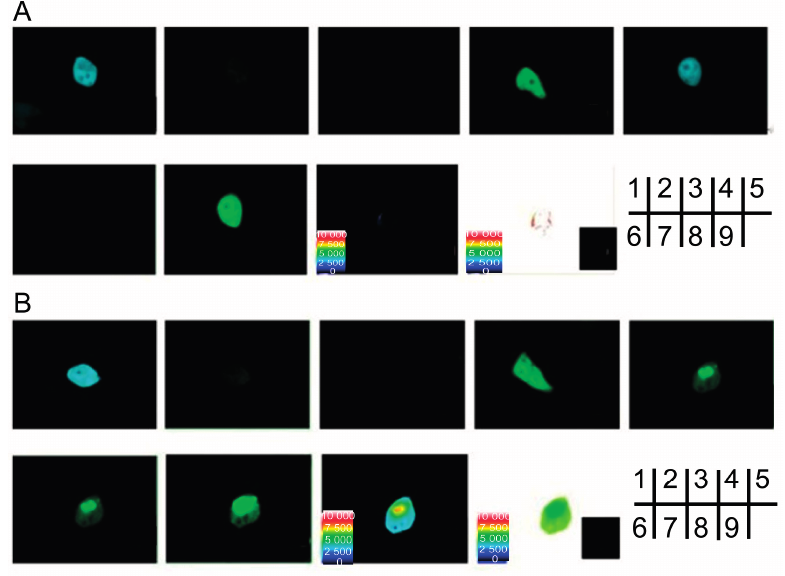
Figure 2. Verification of SelP' and α -tubulin interaction by the sensitized emission method of fluorescence resonance energy transfer (FRET). HEK293T cells were transfected respectively or together with ( A ) the vacant plasmids pECFP-C1 and pEYFP-C1 as negative controls; ( B ) pECFP-C1- SelP' and pEYFP-C1- Tub . (1) and (2) Donor cells were transfected with CFP plasmids, excited at 405 nm, and imaged at CFP channel (1) or YFP channel (2); (3) and (4) Receptor cells were transfected with YFP plasmids and imaged at YFP channel, where the cells were excited at 405 nm (3) or 515 nm (4); (5)–(9) Cells were co-transfected with CFP and YFP plasmids; (5) Cells were excited at 405 nm and imaged at CFP channel; (6) Cells were excited at 405 nm and imaged at YFP channel; (7) Cells were excited at 515 nm and imaged at YFP channel; (8) Diagram of the distance between donor and receptor. (9) FRET efficiency